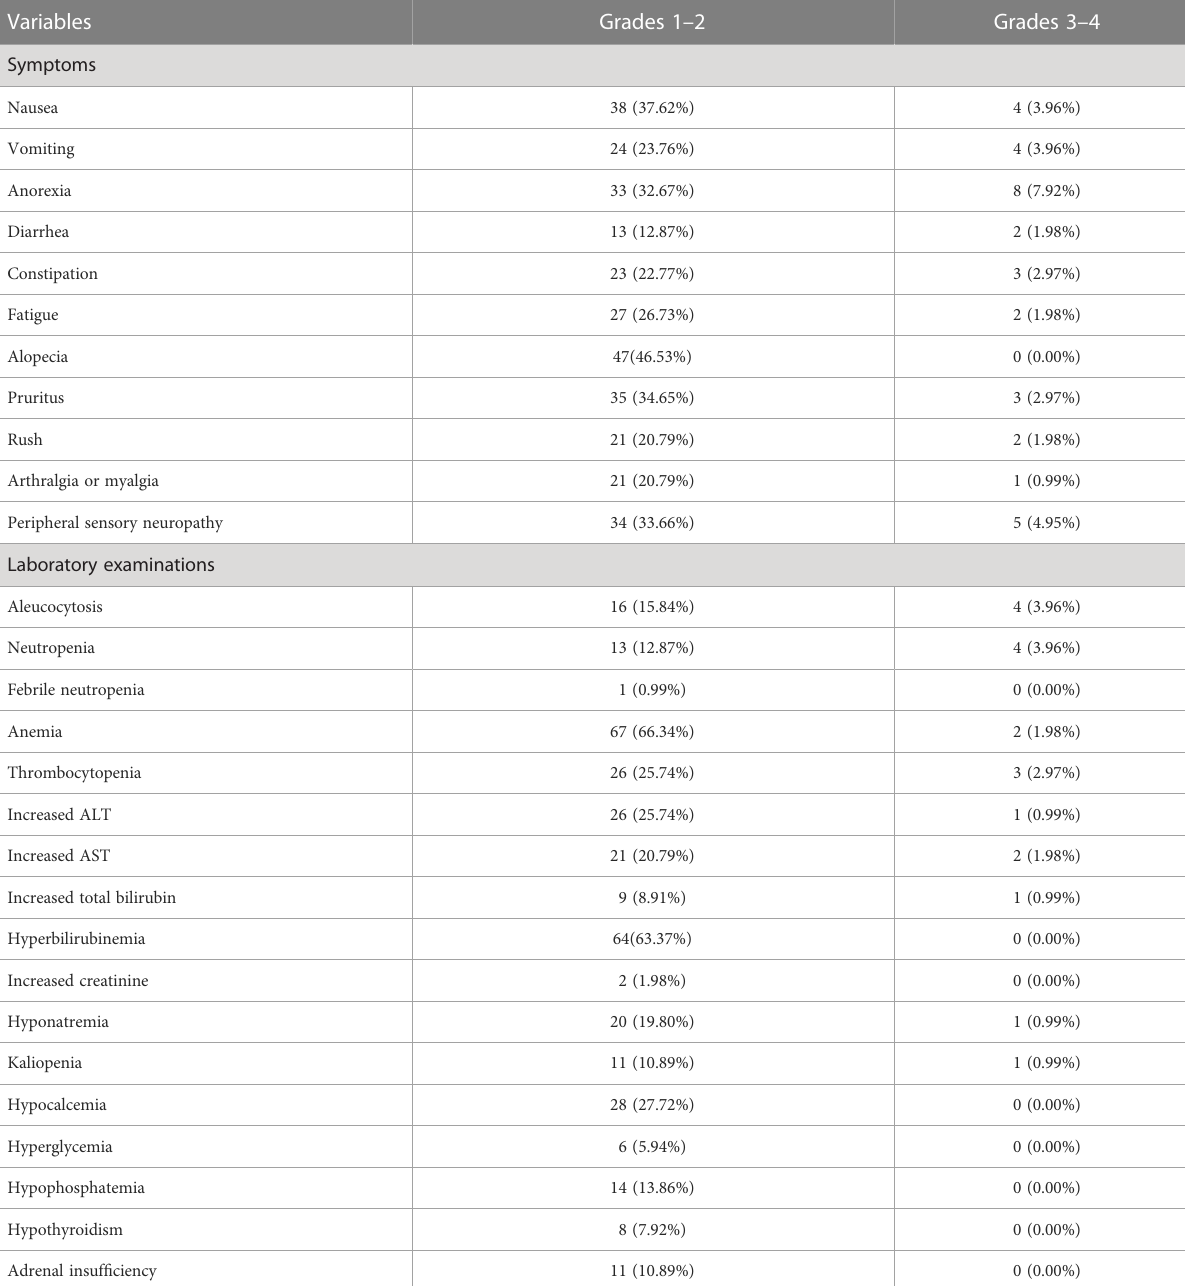
TABLE 2 Adverse events during neoadjuvant